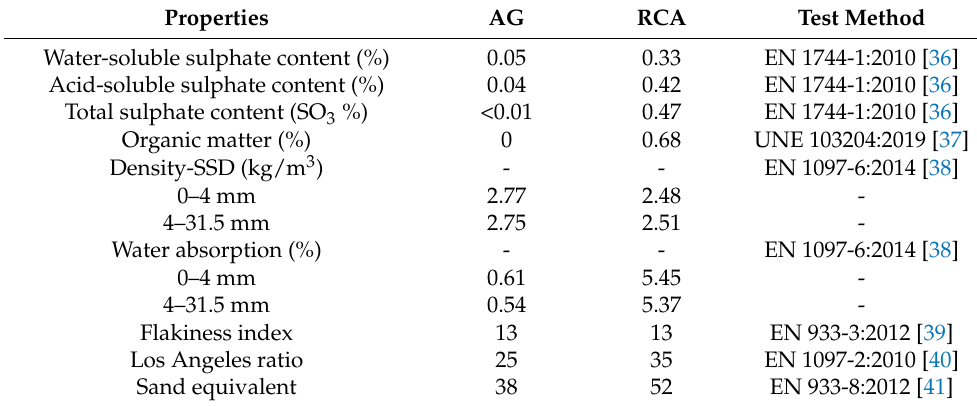
Table 2. Physical and chemical properties of artificial gravel (AG) and recycled concrete aggregates